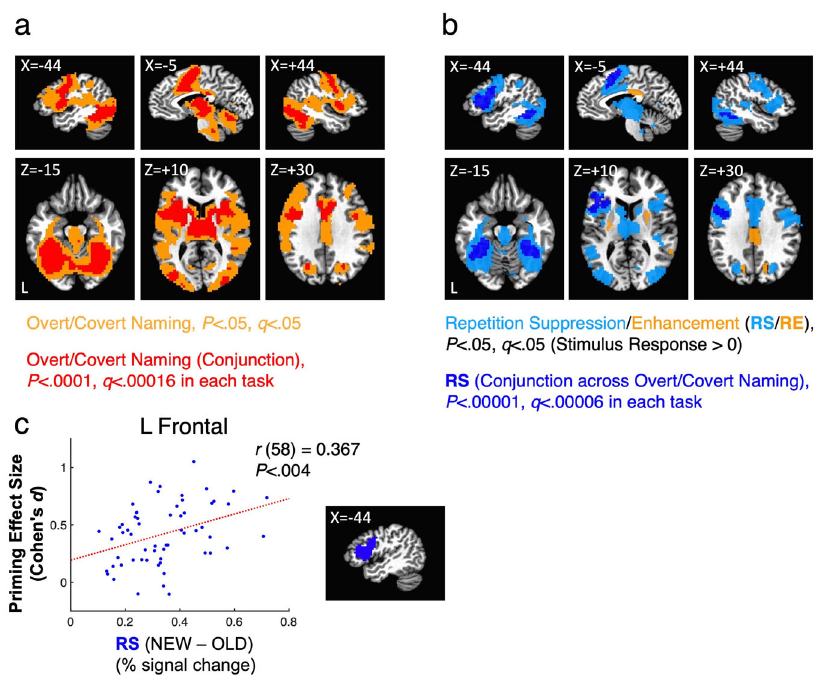
Fig. 3 Regions engaged in object naming and showing repetition effects. a Above-baseline responses to Overt and Covert Naming tasks are shown at two levels of signi fi cance, one at a minimum level of signi fi cance (pooling the tasks, P < 0.05, FDR q < 0.05; shown in orange) and another at a more restrictive level of signi fi cance ( P < 0.0001, FDR q < 0.00016 in each task individually) for which responses can be said to replicate across tasks (shown in red). b Repetition effects, either repetition suppression (blue colors) or repetition enhancement (orange), are shown at two levels of signi fi cance, one at a minimum level of signi fi cance (pooling the tasks, P < 0.05, FDR q < 0.05; suppression shown in light blue, enhancement shown in orange) and another at a